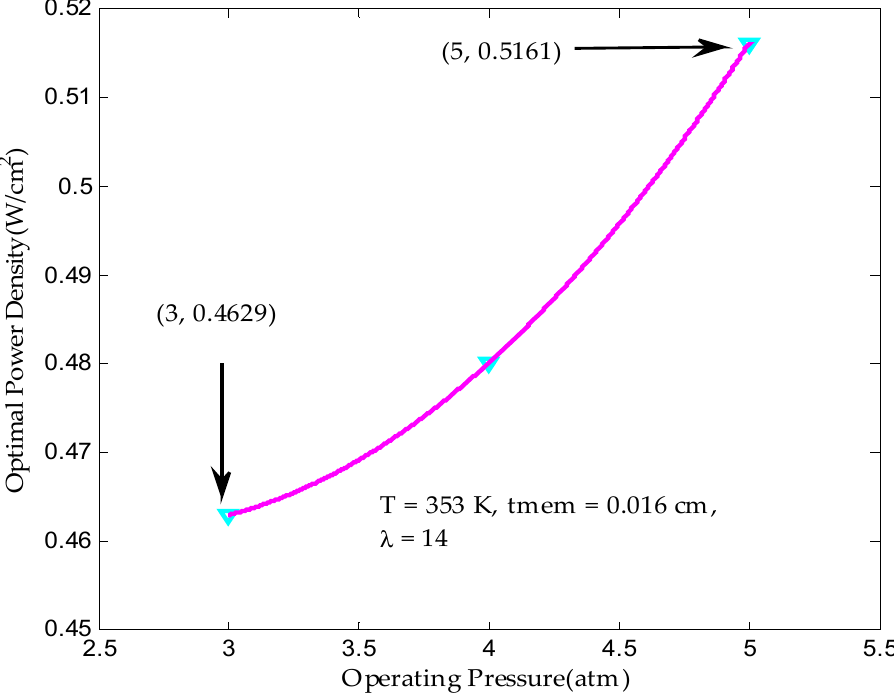
Figure 4. Optimal output power density varying with operating pressure.